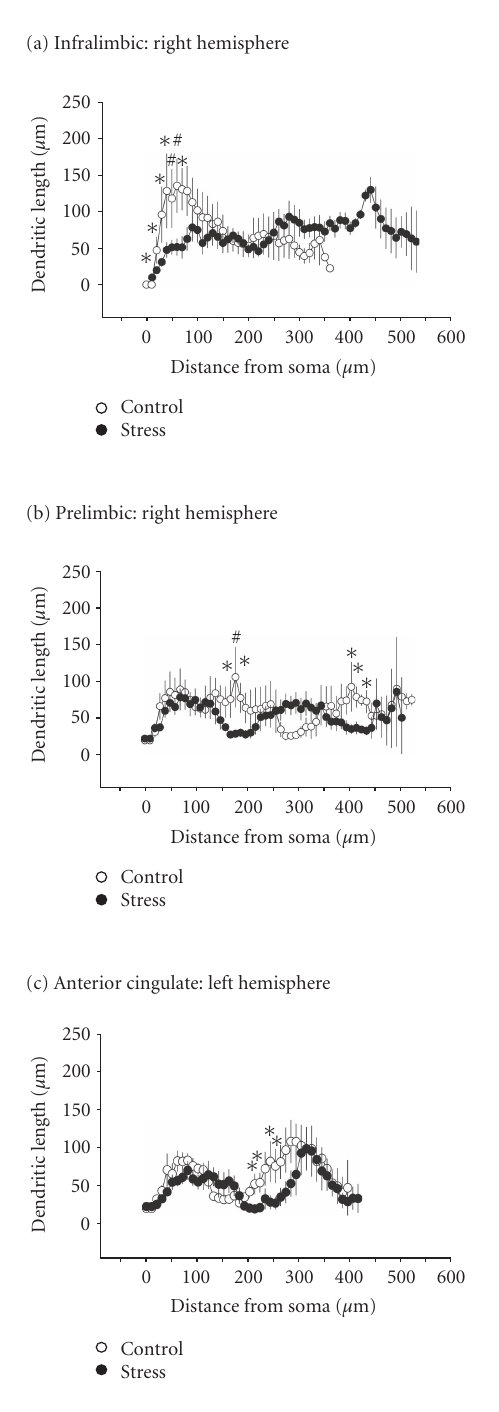
Figure 4: Comparisons of apical dendrites in the right hemispheres of IL and PL, and in the left ACx of stressed (closed circles) and con- trol rats (open circles). Apical dendrites were plotted as a function of distance from the soma center (0). (a) and (b) show the e ff ects of stress in the right hemisphere of the infralimbic and prelimbic, re- spectively. (c) show the e ff ects of stress on the left hemisphere of the anterior cingulate. Data points represent the sum of all dendrites detected at the respective distance (radius) from the soma (mean ± SEM). Symbols indicate significant di ff erences detected within each 10 µ m ring as determined by three-way repeated measures ANOVA ( ∗ P < . 05, # P < .